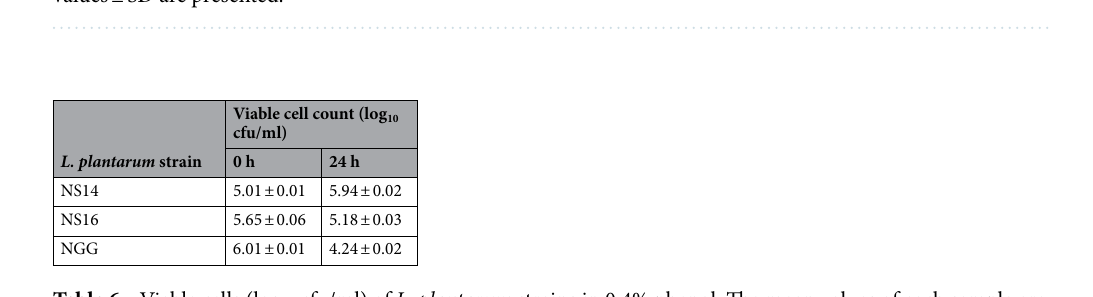
Table 6. Viable cells (log 10 cfu/ml) of L. plantarum strains in 0.4% phenol. The mean values of each sample are presented along with ± SD.